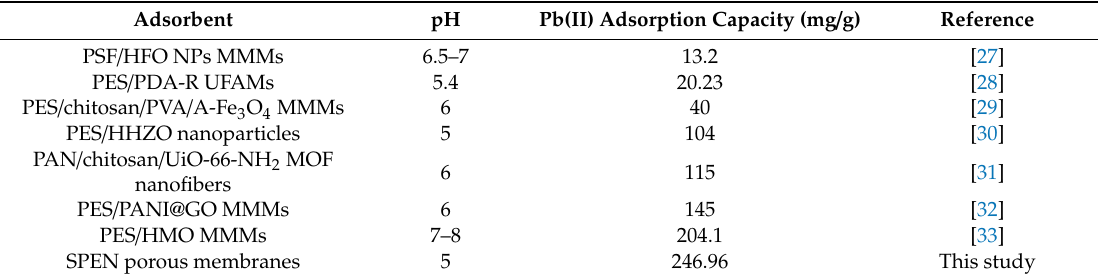
Figure 6. ( a ) Effect of initial concentrations on Pb(II), ( b ) pseudo-first-order, ( c ) pseudo-second-order, and ( d ) and intraparticle diffusion for the adsorption of Pb(II) onto SPEN-CTAB-0%. Table 3. Adsorption capacities of Pb(II) on various adsorbents.